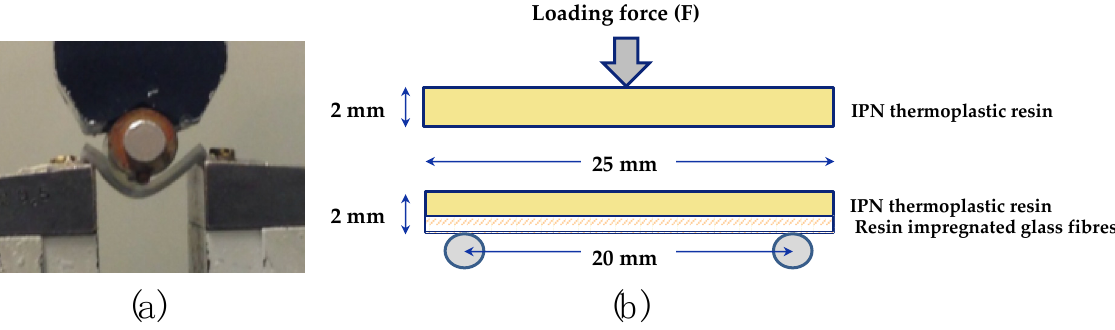
Figure 1. 3-point bending (FS) test ( a ) and the schematic drawings of specimens from front side ( b ): upper; No fibre reinforced specimen and lower; fibre reinforced specimen: a bundle of S2 or E resin impregnated glass fibres is placed on the bottom (tensile) side. Specimen size is 2 mm × 2 mm × 25 mm. The distance between two supports is 20 mm.